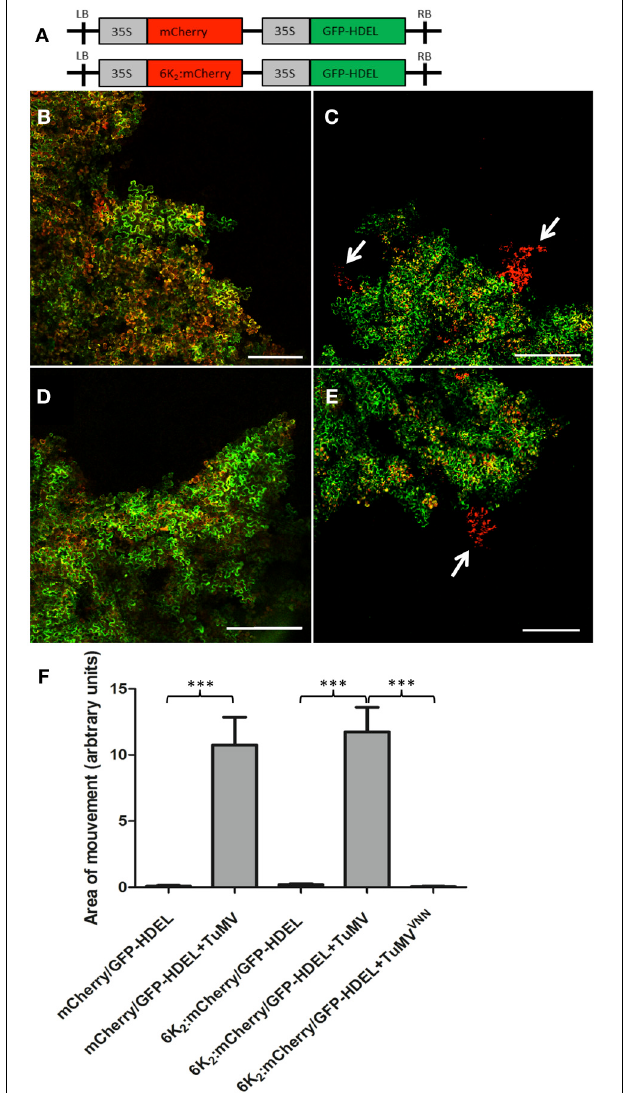
FIGURE 3 | 6K 2 moves intercellularly only when cells are infected with TuMV. (A) Schematic representation of the pCambia/mCherry/GFP-HDEL and pCambia/6K 2 :mCherry/GFP-HDEL. (B,C) Confocal images of cells expressing pCambia/mCherry/GFP-HDEL in mock- (B) or TuMV-infected (C) N. benthamiana plants. (D,E) Confocal images of cells expressing pCambia/6K 2 :mCherry/GFP-HDEL in mock- (D) or TuMV-infected (E) N. benthamiana plants. Arrows indicate areas of mCherry or 6K2:mCherry protein movement. (F) Area of movement has been quantified for 15 N. benthamiana epidermal samples expressing the indicated proteins. Brackets and asterisks indicate statistical differences as follows: ∗∗∗ P -value < 0.001 (extremely significant). Scale bars = 500 µ